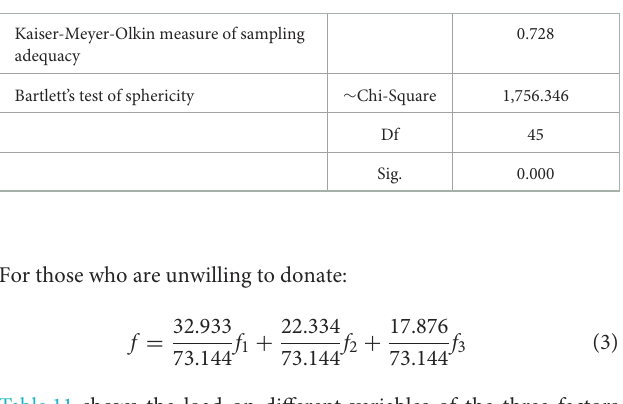
TABLE 6 Reliability statistics.